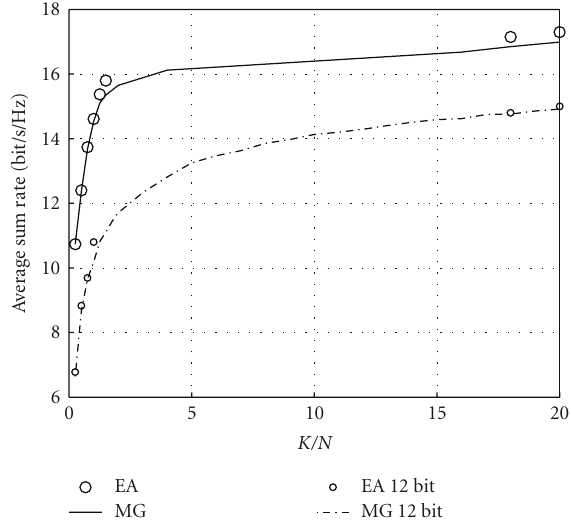
Figure 1: Average sum rate of MG and ES versus of total number of users K